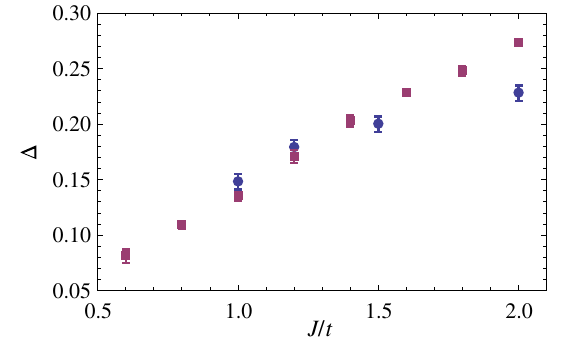
FIG. 8. The optimal value of pairing amplitude Δ , which is the only variational parameter in the projected d þ id wave function, for 24-site (blue circles) and 32-site (red squares)